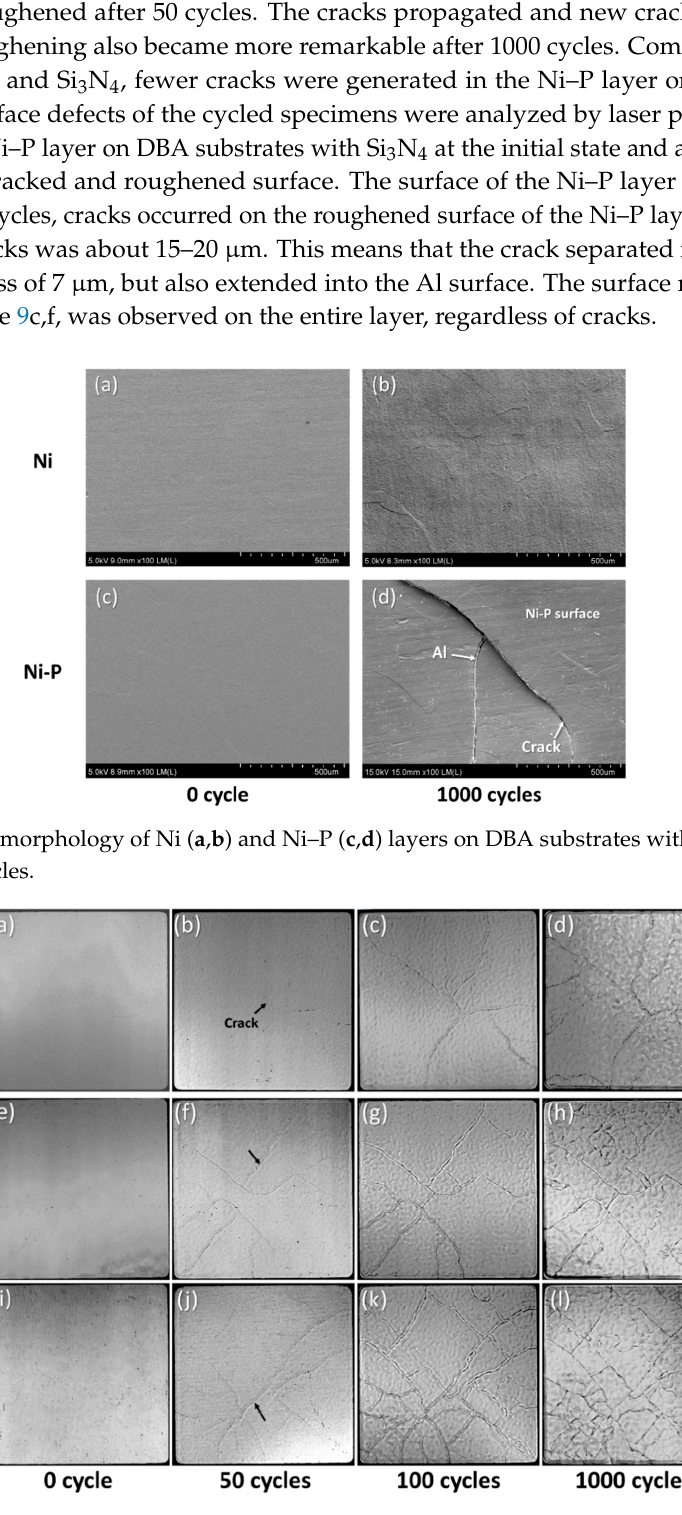
Figure 6. DBA substrates with Al 2 O 3 , AlN, and Si 3 N 4 after 1000 cycles, plated with Ni ( a – c ) and Ni–P ( d – f ).